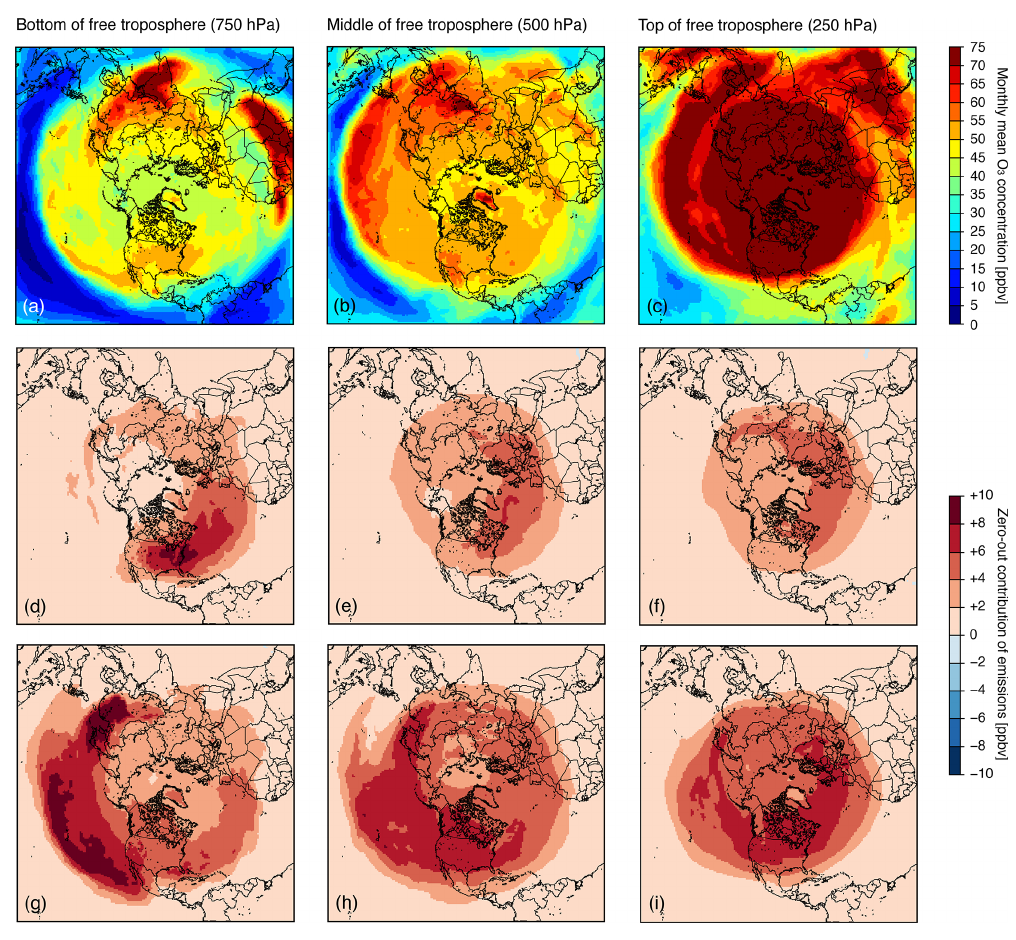
Figure 6. Monthly averaged (a–c) O 3 concentration and zero-out contribution from the (d–f) US and east (g–i) Asia at the bottom of free troposphere (750hPa; a, d, g ), middle of free troposphere (500hPa; b, e, h ), and top of free troposphere (250hPa; c, f, i ).